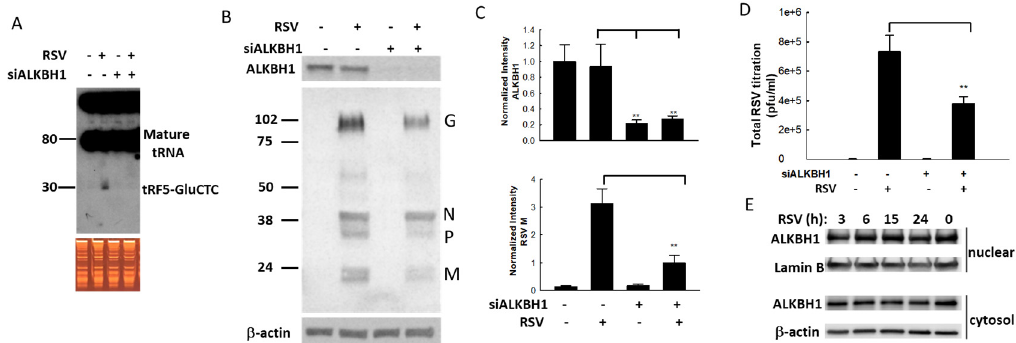
Figure 4. The impact of ALKBH1 on the RSV infection. ( A ) ALKBH1 gene knockdown prevents the induction of tRF5-GluCTC by RSV. The input of total RNAs in mock- and RSV-infected cells were checked by EB staining and induced tRF5-GluCTC was determined by Northern blot. ( B,C ) ALKBH1 gene knockdown decreased the expression of RSV proteins. The ALKBH1 gene knockdown was confirmed by Western blot using an anti-ALKBH1 antibody. The membrane was stripped and reprobed for RSV proteins and β -actin ( B ). Densitometric analysis of the band intensity of ALKBH1 was performed using the histogram function of Adobe Photoshop. Results are shown after corrections to β -actin. Results are representative of three independent experiments ( C ). ( D ) The impact of ALKBH1 on RSV virus titration was also determined. The double asterisk represents p values of <0.01. Data are shown as means ± SE. ( E ) The nuclear and cytosolic expression of ALKBH1 along RSV infection. The membranes were stripped and reprobed for lamin B as a loading control for nuclear fraction, while β -actin was used as a loading control for cytosol fraction.